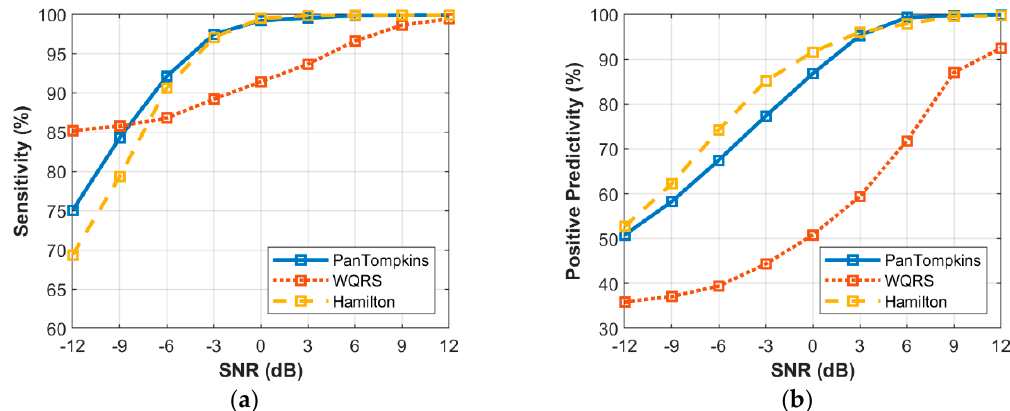
Figure 11. Relationship between the performance of beat detection and EM artefact with abnormal signal for the record 200: ( a ) sensitivity with SNR; ( b ) positive predictivity with SNR.